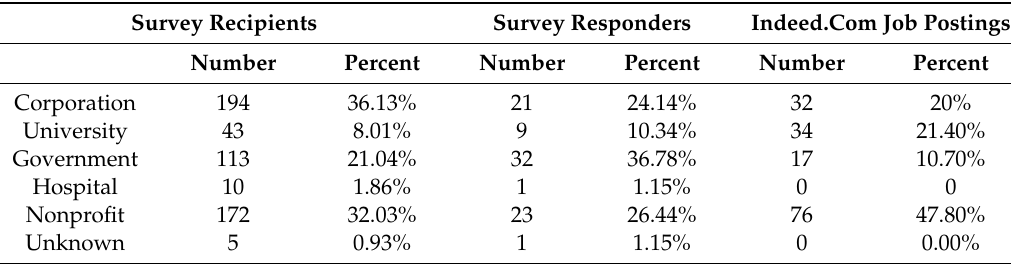
Table 3. Survey recipients vs. responders vs. Indeed.com postings.